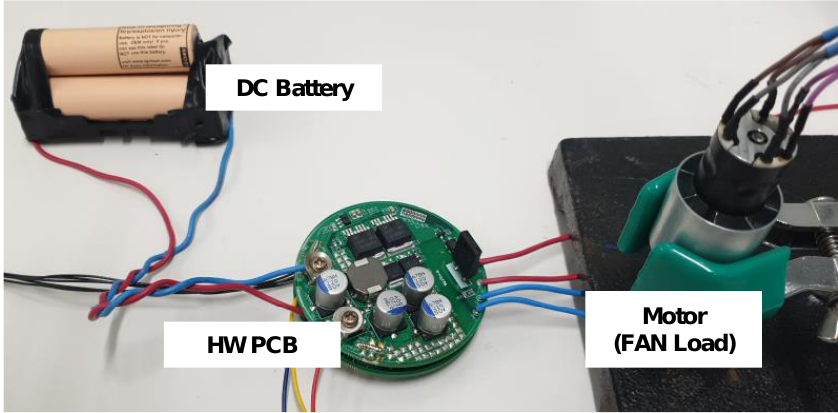
Figure 10. The test configuration used in our study: ( a ) HW PCB front side; ( b ) HW PCB back side.